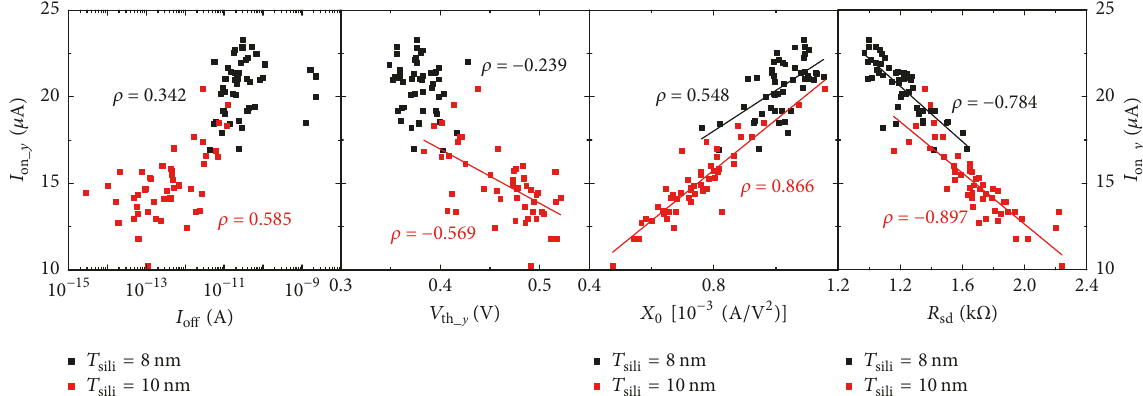
− 𝑉 at ( 𝑉 ) of 0.8 V with respect to the DC parameters ( 𝐼 on 𝑦 gs th 𝑦